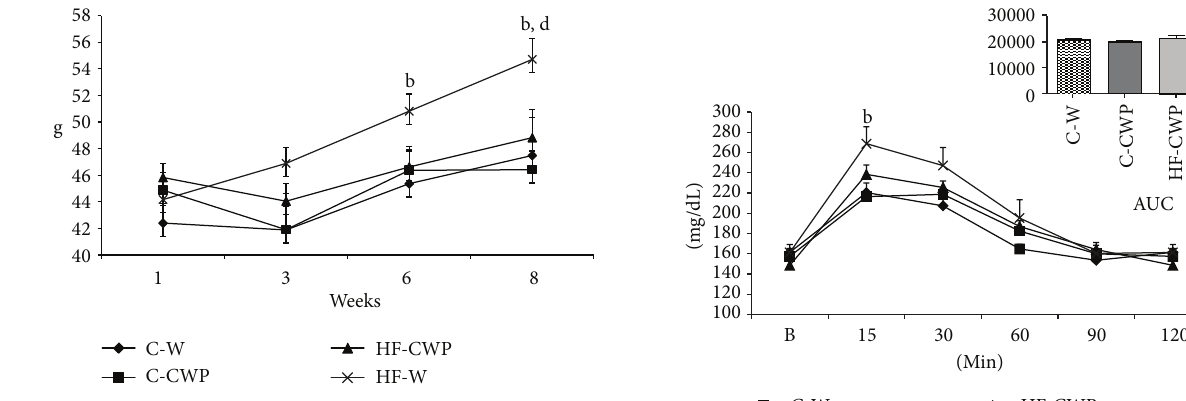
Figure 2: Evolution of the average gain in body mass (g) of mice for eight weeks of treatment with high fat diet (HF) or control normocaloric (C) associated with gavage of coacervate (CWP) or water (W). Data submitted with an average ± EPM. (b) C-W versus HF-W and (d) HF-CWP versus HF-W. ( 𝑃 < 0.05 ). differences among the groups. Pearson’s correlation was used to assess the associations between the analyzed variables.